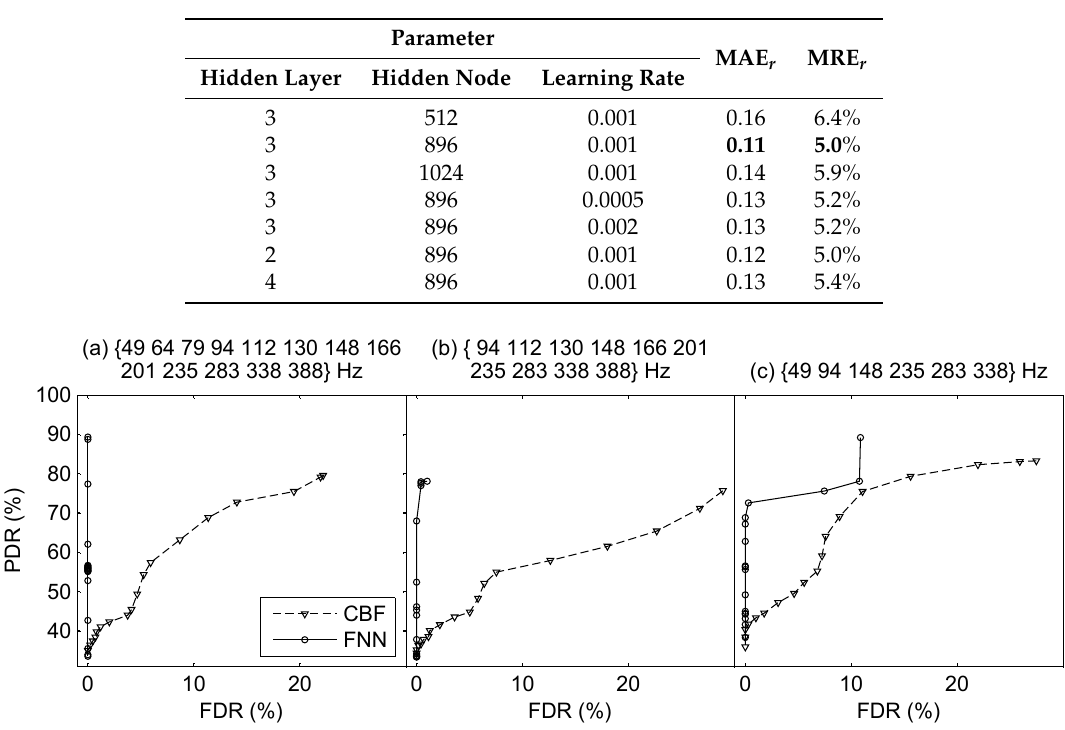
Table 7. MAE r and MRE r comparison with different parameters of LSTM-RNN using the experimental data.